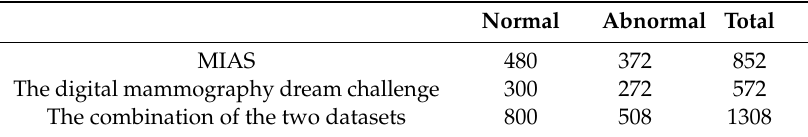
Table 1. The number of samples used for each